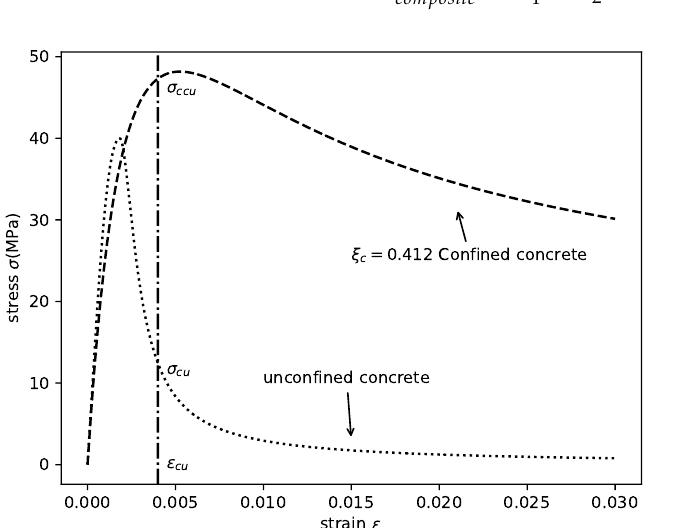
Figure 2. Axial stress of confined concrete and unconfined concrete at the ultimate state of the column ([32,33]).